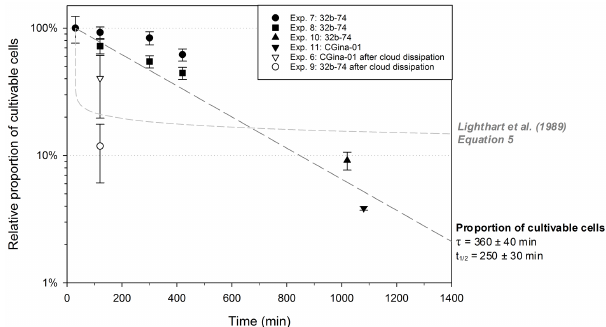
Figure 2. Temporal evolution after aerosolization of the proportion of cultivable cells (cultivability) in impinger samples in P. syringae 32b-74 and P. fluorescens CGina-01, relative to the cultivability measured 30min after spraying cell suspensions, in the absence of cloud (black symbols) or after cloud formation and dissipation (open symbols). Error bars are standard deviations from the mean of triplicate samples. The black dashed curve shows fitted expo- nential temporal decay of cultivability in the absence of a cloud (Pearson’s r = 0 . 911, n = 9). The corresponding calculated time constant ( τ ) and half-life time ( t 1 / 2 ) are indicated on the right of the figure (mean ± standard deviation). Data using the Eq. (5) from Lighthart (1989) are also plotted for comparison (dashed grey line); this model valid for an “average” bacterial strain fits our data with a Pearson’s r of 0.517 ( n = 9).